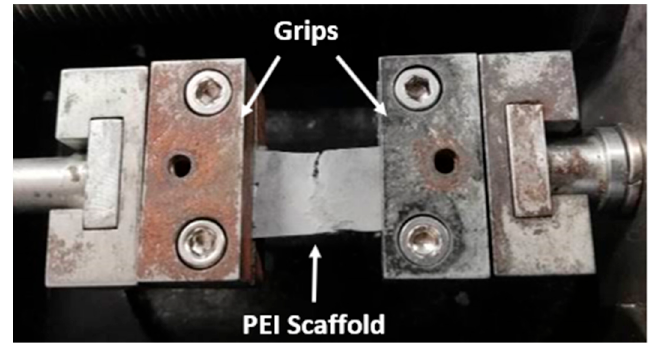
Figure 9. Snapshot during uniaxial tensile tests, indicating the brittle fracture of PEI membranes .